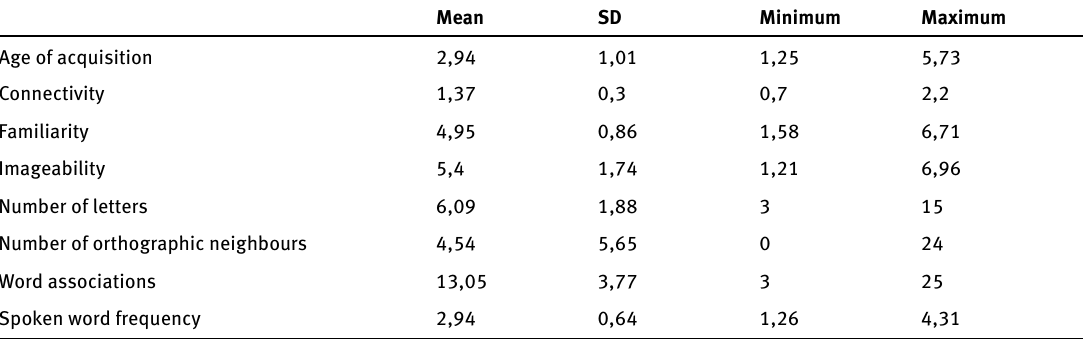
Table 1: Descriptive statistics for all the predictor variables considered in the